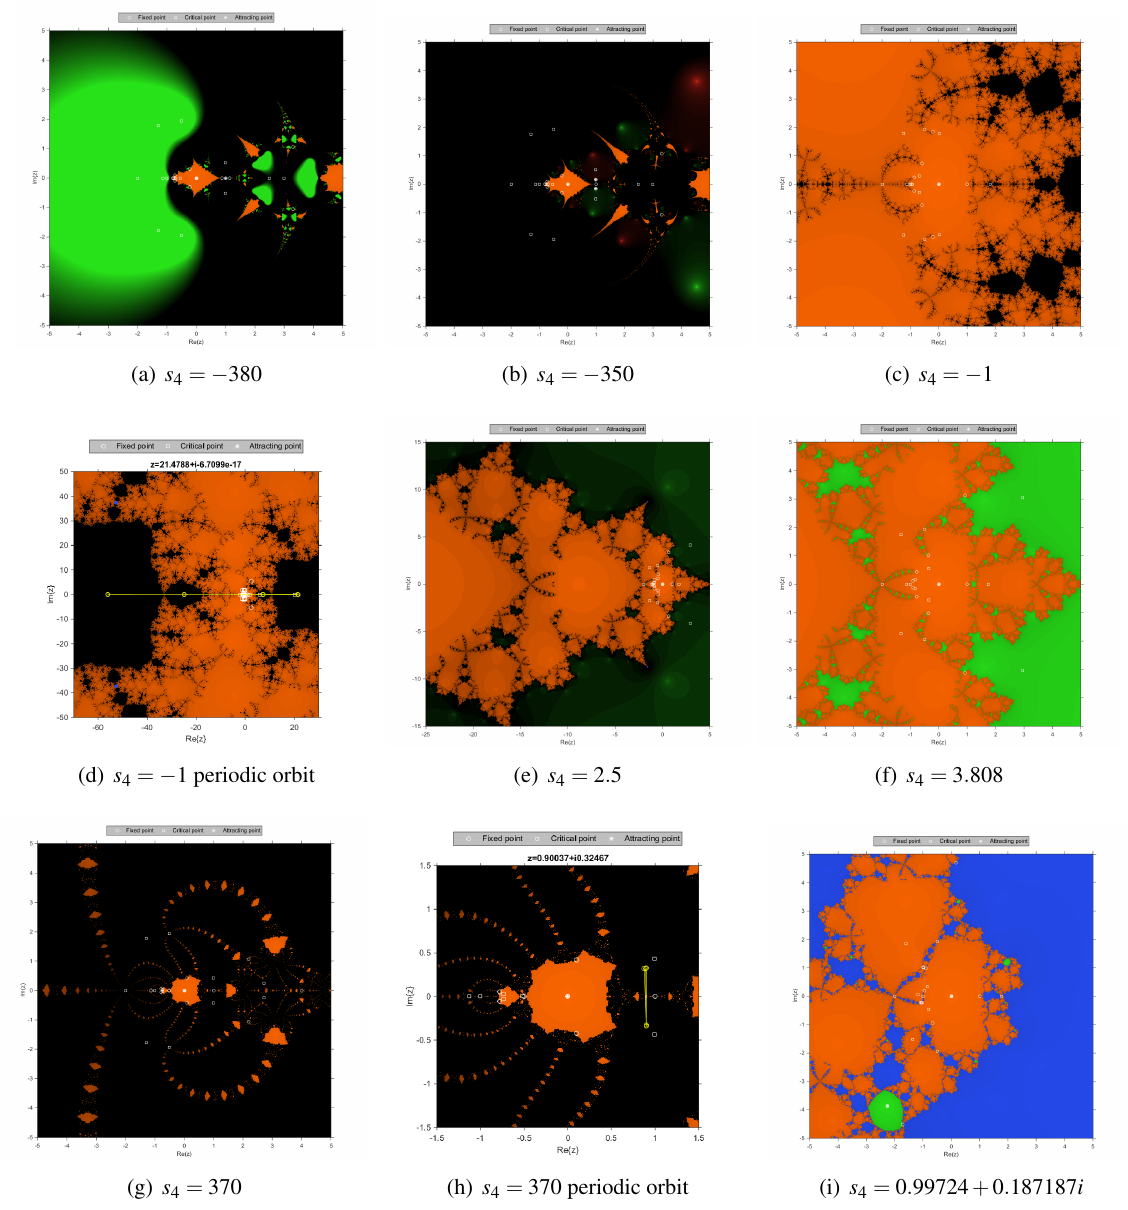
Fig. 3 Dynamical planes with unstable